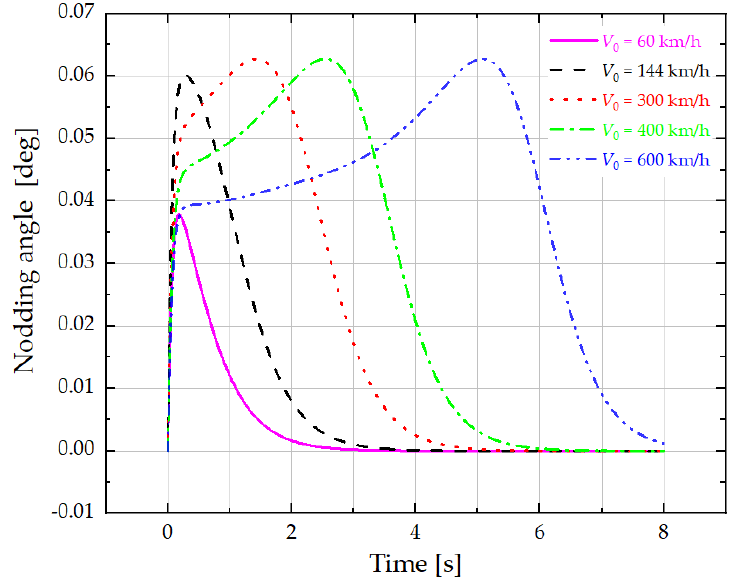
Figure 13. The change process in the nodding angle ( β ) of the bogie at initial speeds of V 0 = 60 km/h, 144 km/h, 300 km/h, 400 km/h and 600 km/h and under 10 mm air